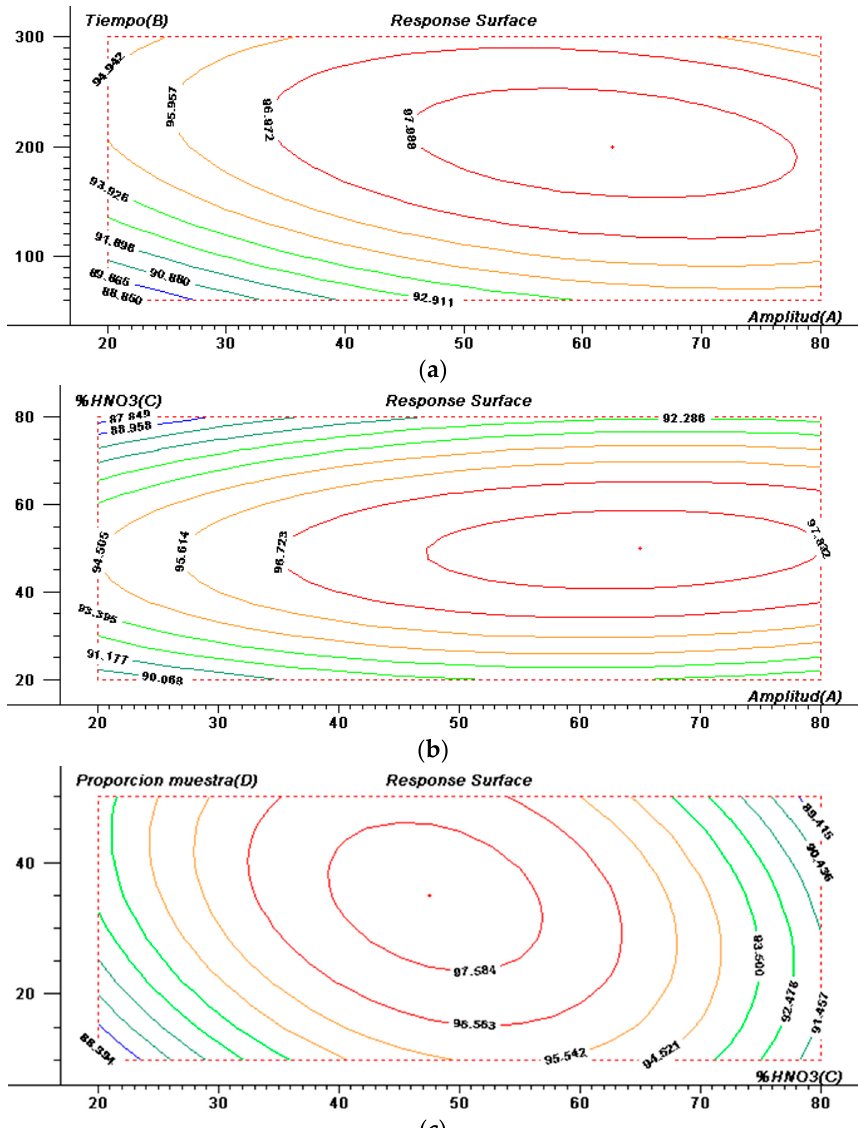
Figure 2. Response surfaces (contour plots) estimated for ( a ) Time vs. Amplitude; ( b ) % HNO 3 vs. Amplitude; ( c ) Sample/solvent ratio vs. % HNO 3 after model